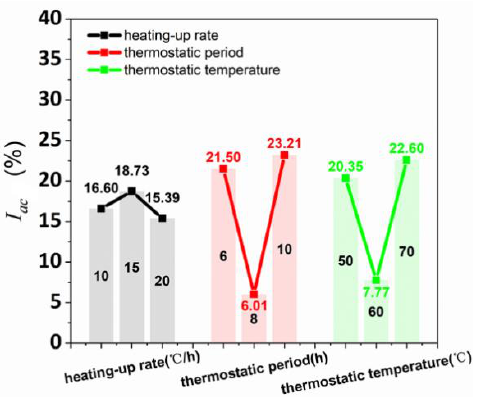
Figure 9. I ac affected by various heating-up rates, thermostatic periods, and thermostatic tempera- tures.